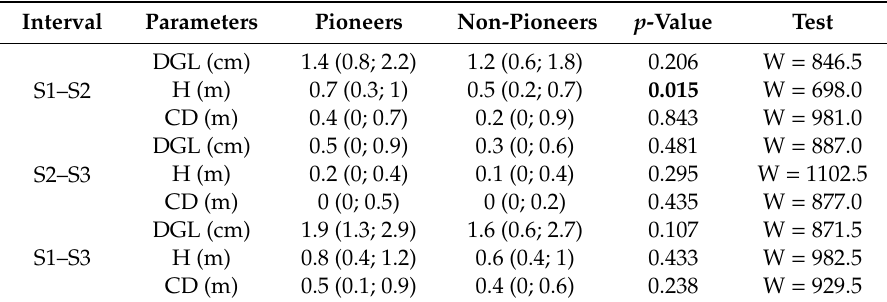
Table 3. Growth in diameter at ground level (DGL), plant height (H), and canopy diameter (CD) of all individuals ( n = 100) by ecological groups (pioneers and non-pioneers), among the three surveys (S1, November 2017; S2, April 2018; and S3, October 2018). Significant di ff erences ( p < 0.05) are in bold. Data are shown as median (with first and third quartiles).